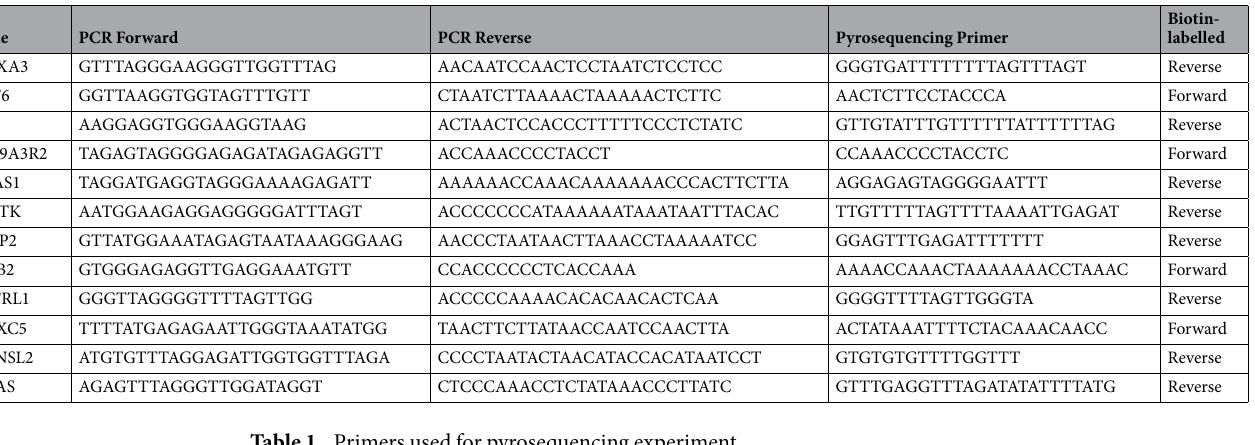
Table 1. Primers used for pyrosequencing